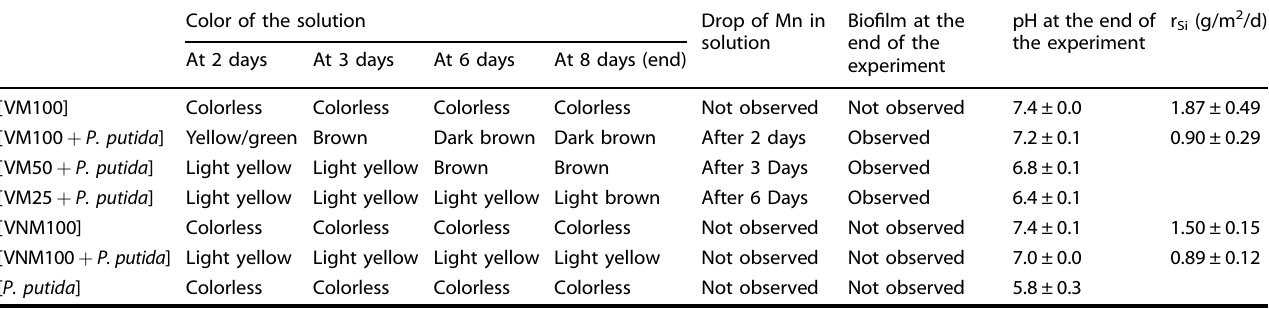
Standard deviations represent the experimental uncertainties calculated on the two set of experiments. Initial pH was 6.5 ±0.1 for all conditions and all the solutions were colorless at the beginning of the